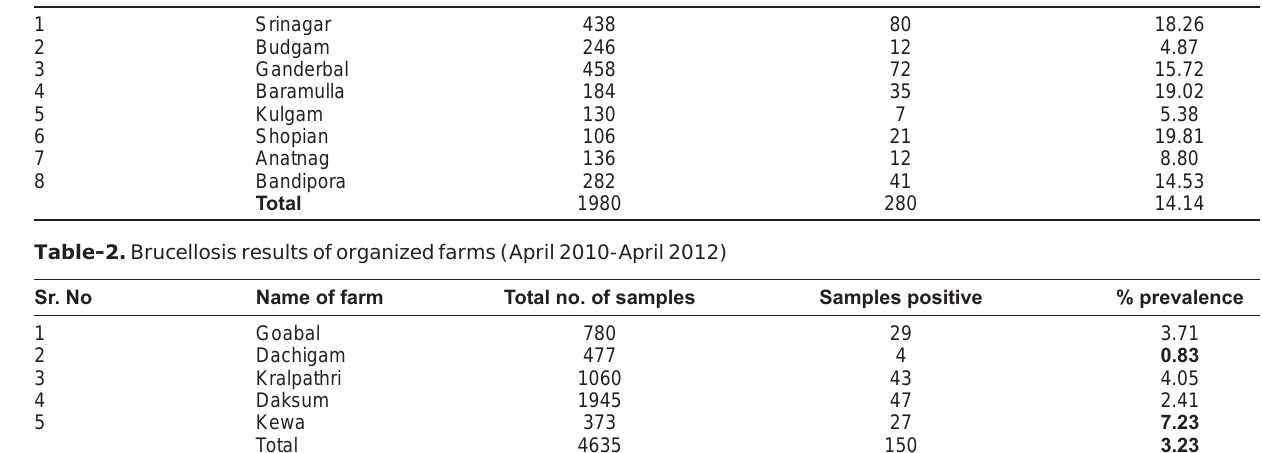
Table-1. Brucellosis picture from received and randomly collected samples (April 2010-April 2012) Sr. No